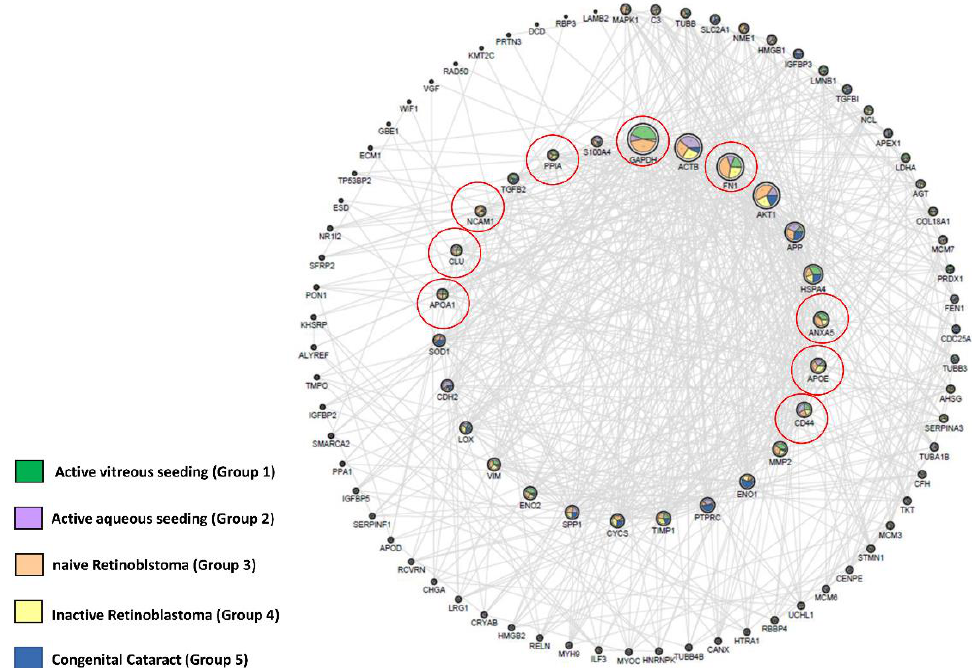
Figure 3. The network represents the interactions between 96 genes coding proteins identified overlapping the polypeptides associated with RB, selected via Open Target, and the proteins identified in our study groups (including the congenital cataract group). The nodes have dimensions related to the degree of connection, and the internal circumference shows the most connected proteins, with a degree > 15. The outer circumference shows the less connected proteins (degree ≤ 15); therefore, of smaller dimensions. Connections are only present if the confidence level of the string is > 0.4. The coloring of the nodes is a function of the average intensity of each group measured in mass spectrometry, normalized for graphic reasons on a scale of 1–100. The coloring and the percentage distribution of the node were preformed using the layout tools in Image/Chart of Cytoscape.